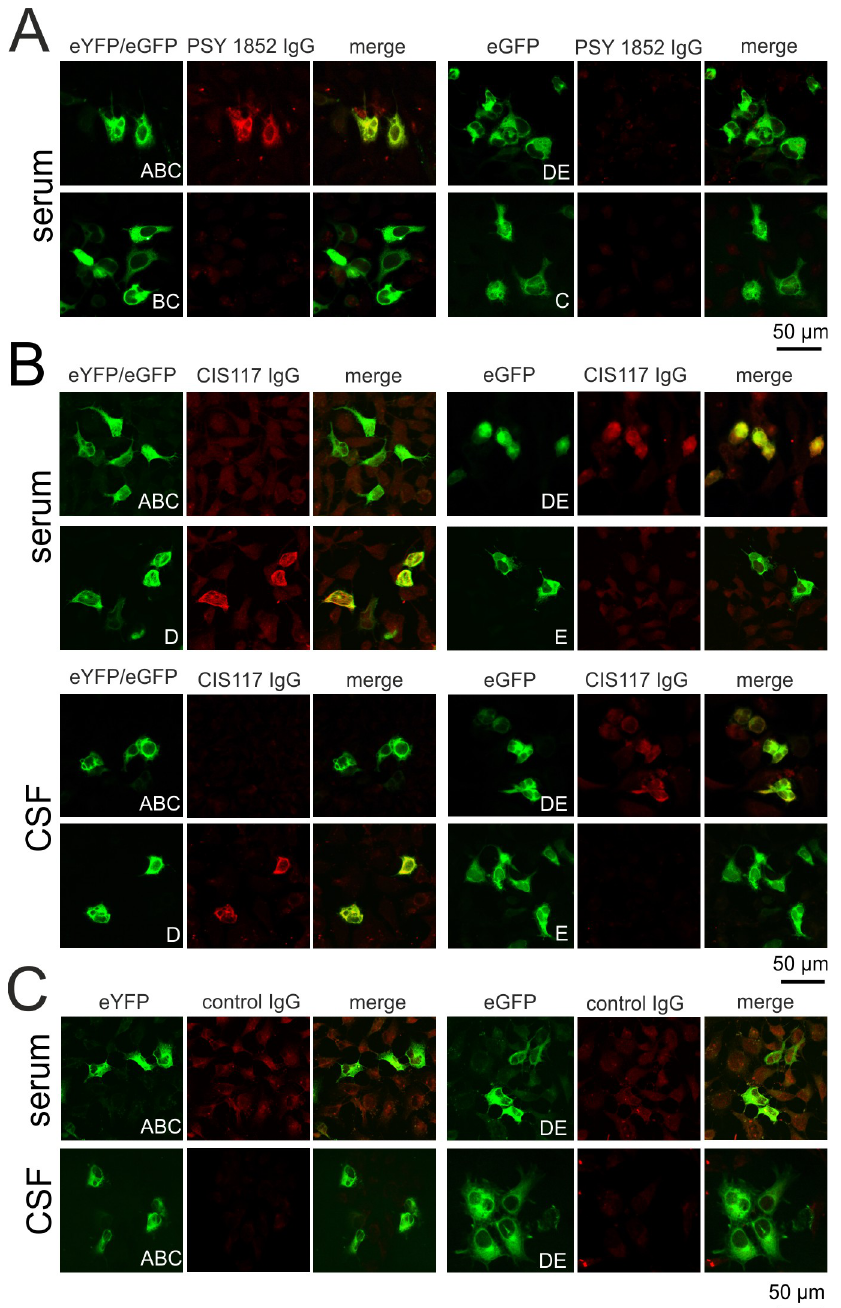
Fig 2. Serum IgG autoantibodies against the A-domain of a patient with bipolar affective disorder and serum and CSF IgG autoantibodies against the D-domain of a patient with a clinically isolated syndrome (CIS). (A) HEK293 cells were transfected with eYFP-tagged synapsin I fragment ABC, eGFP-tagged DE, BC or C. Cells were incubated with patient serum at a dilution of 1:320. Bound IgG was detected using an Alexa 594-coupled secondary antibody to the Fc fragment of human IgG. The patient’s serum demonstrated positive immunoreactivity that co-localized with the eYFP tag of synapsin ABC, but with none of the other constructs. (B) HEK293 cells were transfected with eYFP-tagged synapsin I fragment ABC, eGFP-tagged DE, D or E. Cells were incubated with patient serum or CSF at a dilution of 1:320. Bound IgG was detected using an Alexa 594-coupled secondary antibody to the Fc fragment of human IgG. Both the patient’s serum and CSF demonstrated positive immunoreactivity that co-localized with the eGFP tag of synapsin DE and the single D-domain, but with none of the other constructs. (C) Serum and CSF of two healthy controls (control IgG) did not bind to cells transfected with synapsin ABC or DE.